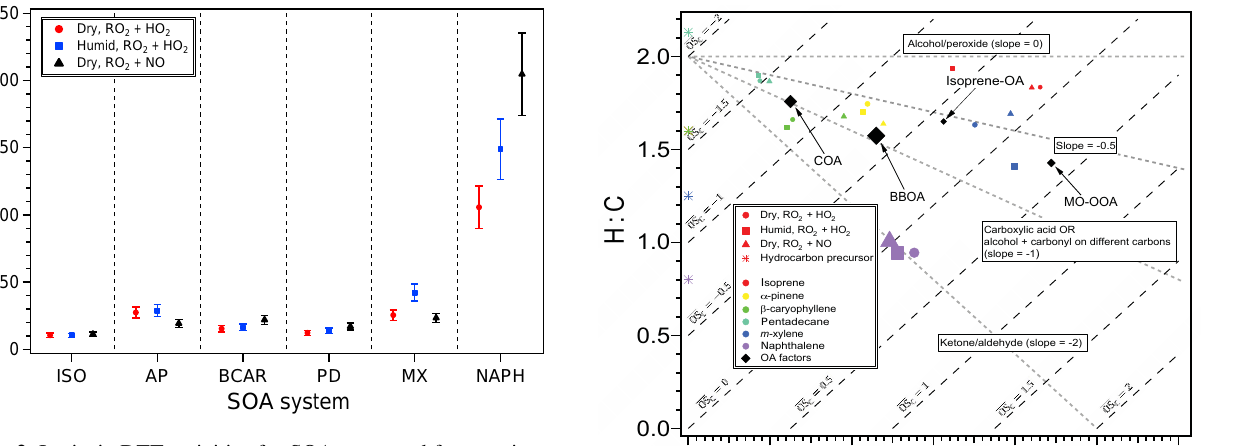
Figure 2. Intrinsic DTT activities for SOA generated from various hydrocarbon precursors (ISO: isoprene, AP: α -pinene, BCAR: β - caryophyllene, PD: pentadecane, MX: m -xylene, and NAPH: naph- thalene) under various conditions (red circles: dry, RO 2 + HO 2 ; blue squares: humid, RO 2 + HO 2 ; and black triangles: dry, RO 2 + NO). Dry RO 2 + HO 2 experiments were repeated to ensure reproducibil- ity in SOA generation and collection. Error bars represent a 15% coefficient of variation (Fang et al., 2015b).